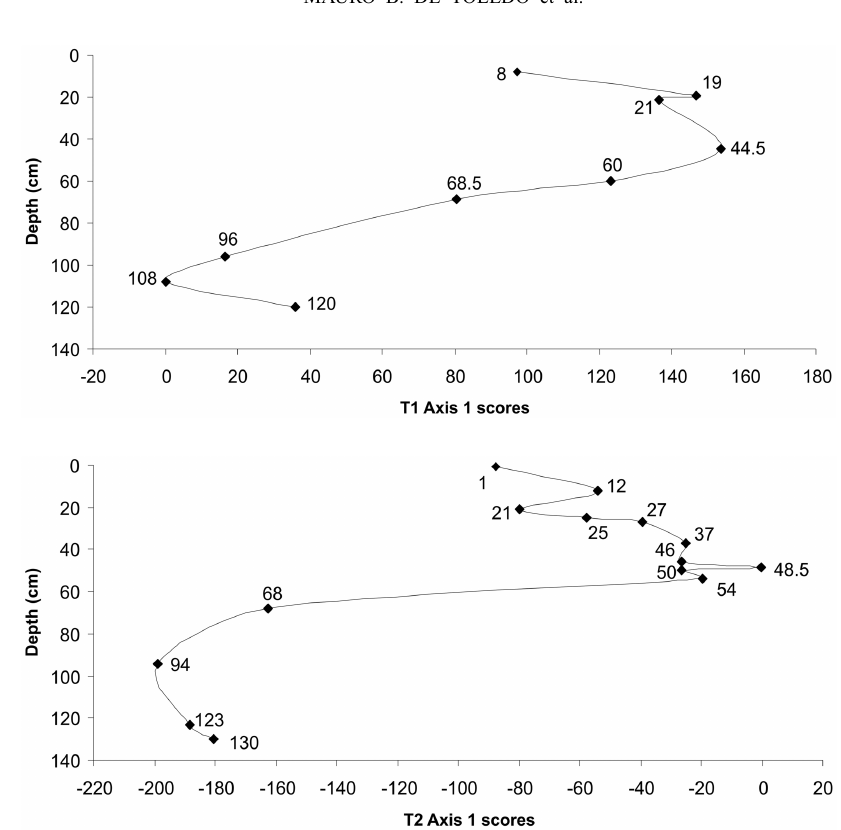
Fig. 3 – DCA scores from Axis 1 plotted against sample depths (cm) from T1 (at the top) and T2 (at the bottom). Community changes are directional rather than chaotic, showing progression of plant community from one state to another. The major change took place between 70 and 55